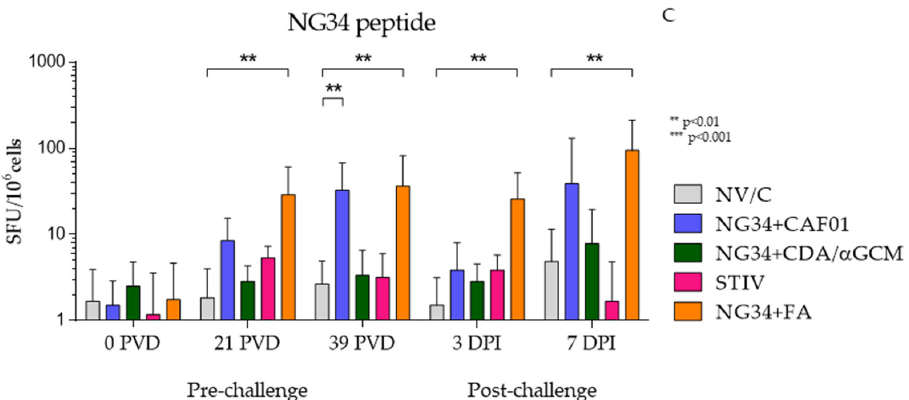
Figure 3. IFN γ ELISPOT results obtained in stimulated PBMCs from blood collected during the study with UV inactivated pdm09 H1N1 A/Human/Catalonia/063/2009 ( A ); recombinant HA1 ( B ) and NG34 peptide ( C ).